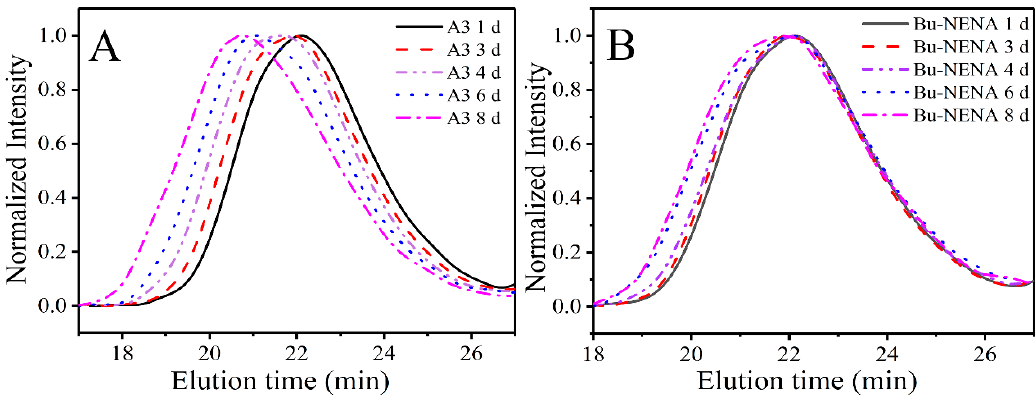
Figure 6. Gel permeation chromatography (GPC) curves of the uncrosslinked polymer in PTPET after different times, ( A ) A3 and ( B ) Bu-NENA.